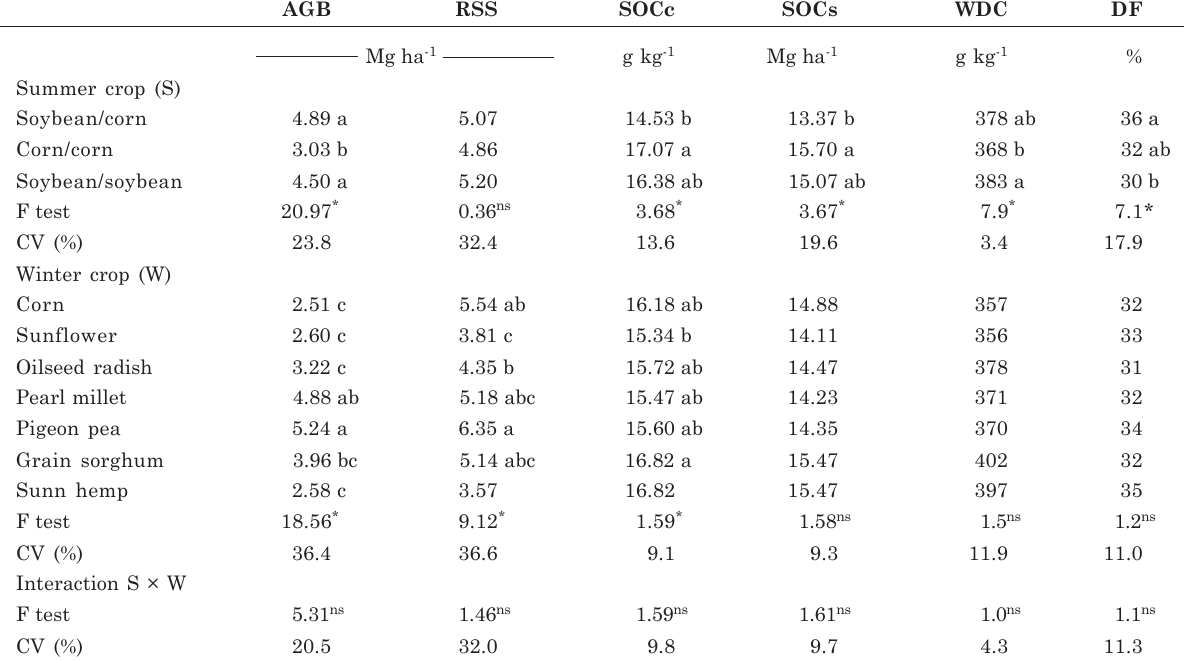
Table 1. Above-ground biomass (AGB) and residues on the soil surface (RSS) produced by winter crops, and soil organic carbon content (SOCc), soil organic carbon stock (SOCs), water-dispersed clay (WDC), and degree of flocculation (DF) determined at the 0-0,10 m depth of an Oxisol under summer and